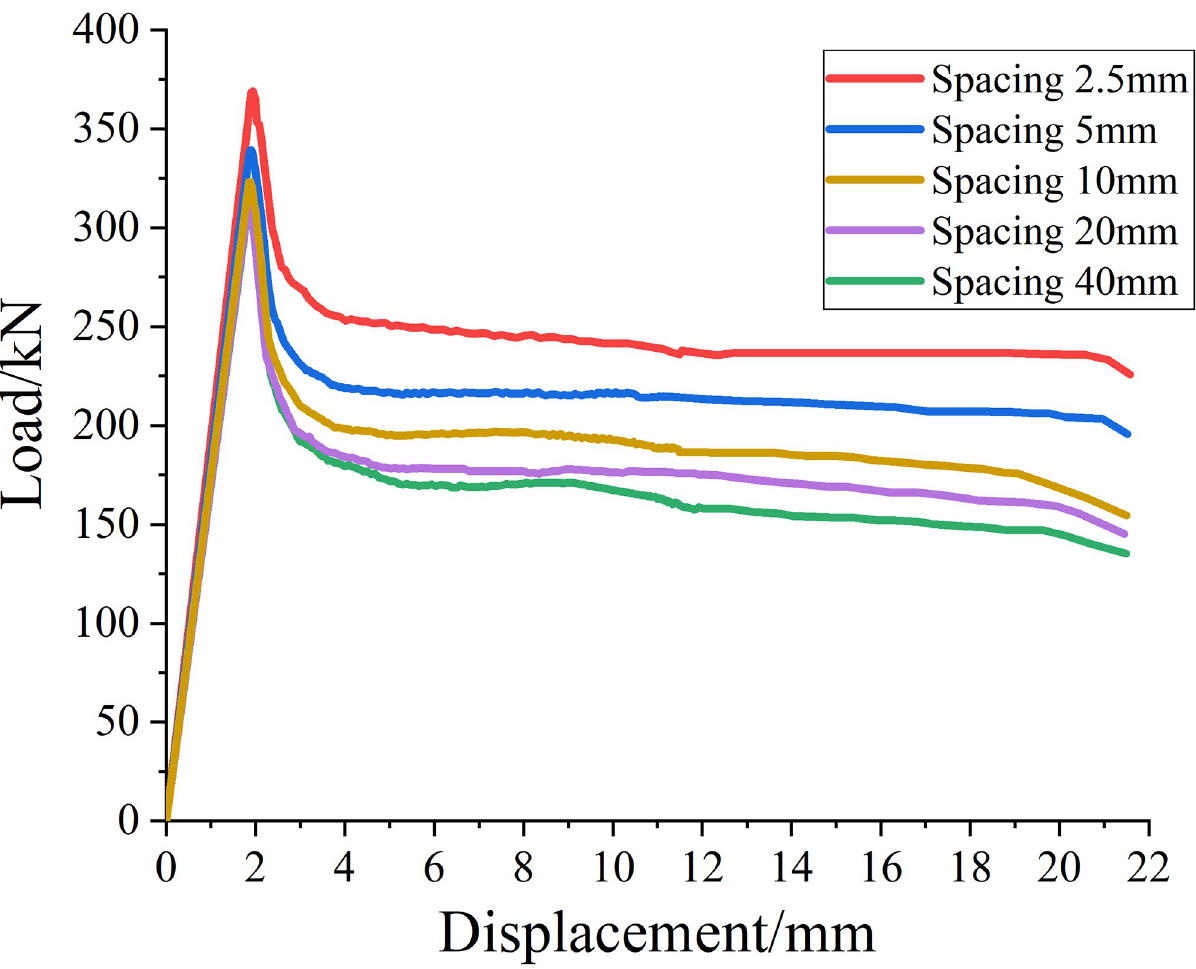
Fig 17. Load-shift curve of specimens with different reinforcement spacing of SMA wires.